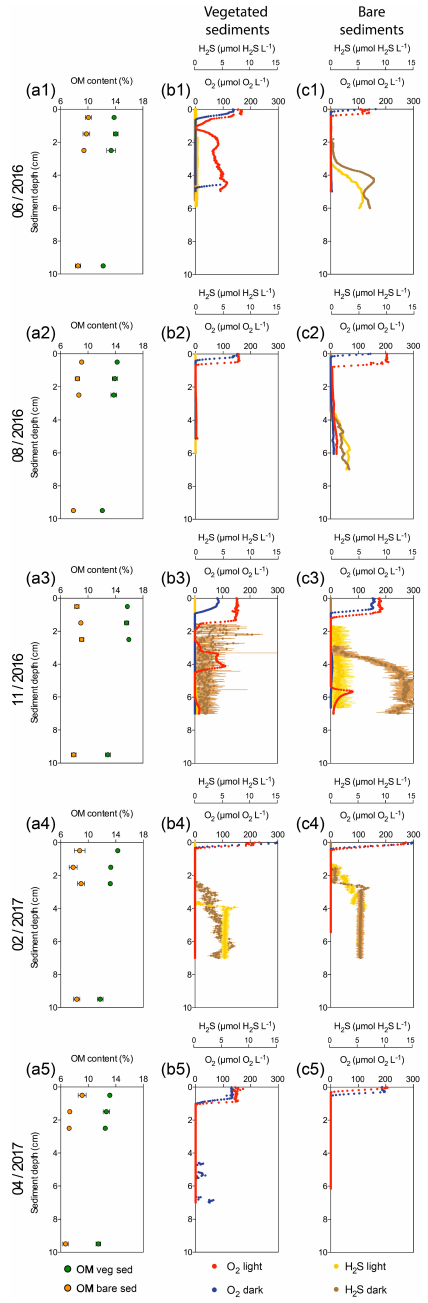
Figure 1. Characterization of Enhalus acoroides seagrass vege- tated sediments and adjacent bare sediments at five sampling times throughout the year. (a1–a5) Sediment organic matter content in vegetated (green dots) and bare (orange dots) sediment horizons. (b1–b5) Vegetated sediment O 2 microprofiles under light (red) and dark (blue) incubations and H 2 S microprofiles during light (yellow) and dark (brown) incubations (no data available for H 2 S profiles on the last sampling). (c1–c5) Bare sediment O 2 microprofiles under light (light red) and dark (dark red) incubations and H 2 S micro- profiles under light (yellow) and dark (brown) incubations (no data available for H 2 S profiles on the last